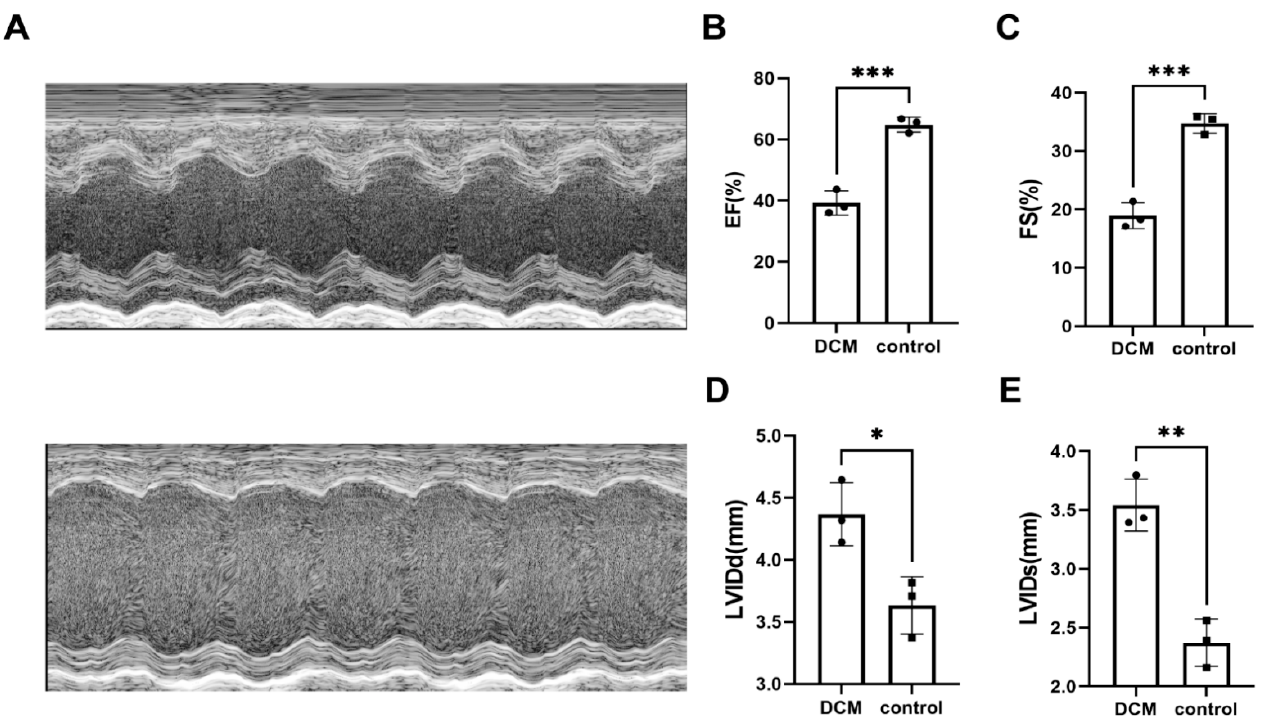
Figure 4. Representative echocardiograms ( A ) and related cardiac function indices ( B – E ) of healthy and DCM mice. * represent p -value < 0.05; ** represent p -value < 0.01; *** represent p -value < 0.001.